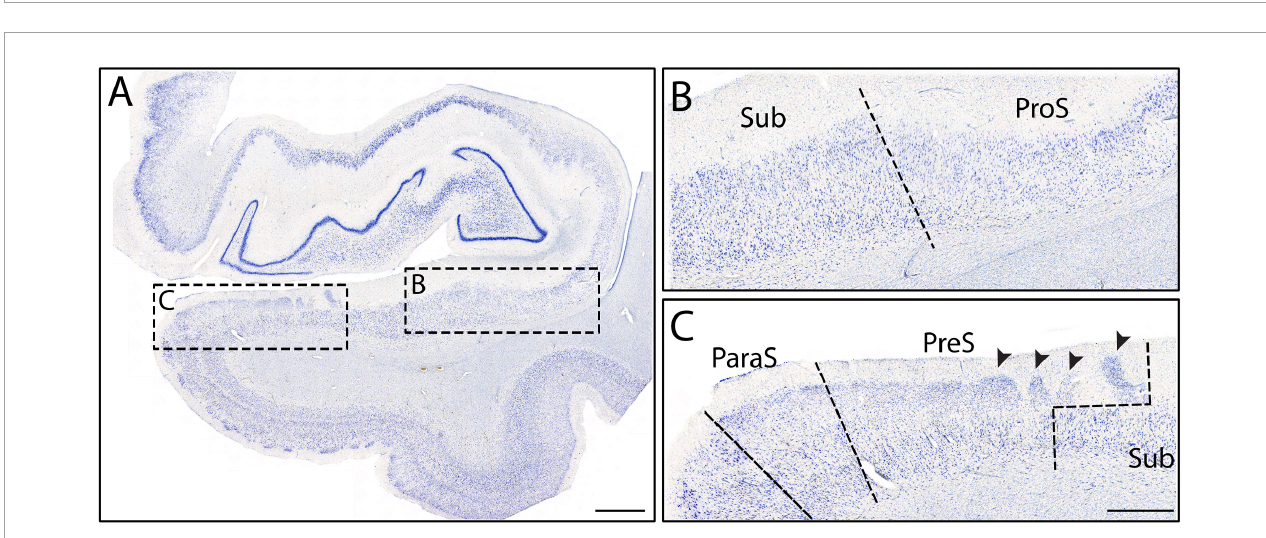
FIGURE5 Macro (A) and mesoscopic views (B,C) of the subicular cortices from Case 3. Panel (B) shows ProS and Sub, while panel (C) shows ParaS, PreS, and Sub. Note the presubicular clouds overlay the distal part of Sub (C) , resulting in the staircase, or oblique boundary. Arrowheads point to the presubicular clouds. Medial to ParaS is the entorhinal cortex. Magnification bar for panel (A) : 2 mm, for panels (B,C) : 1